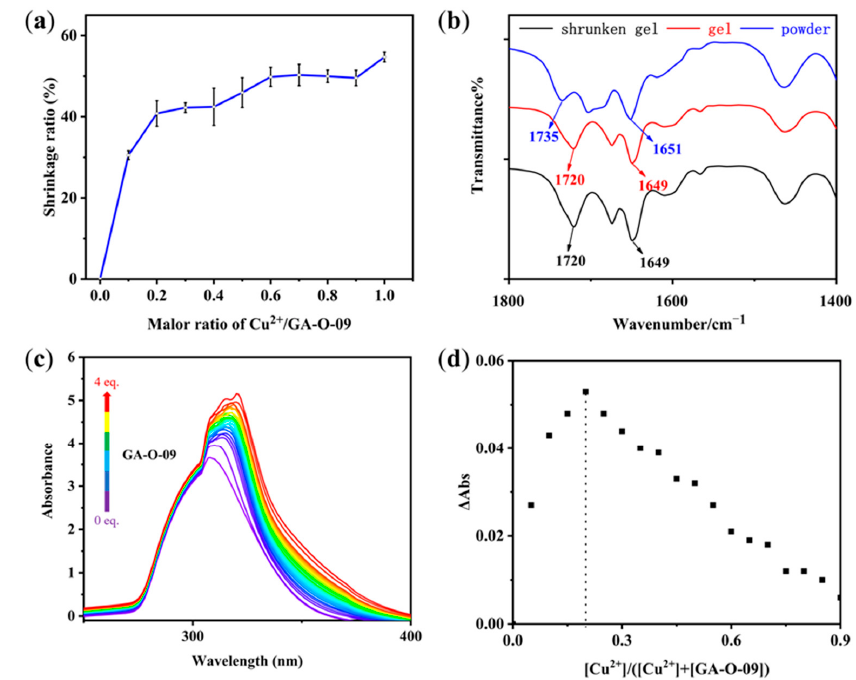
Figure 1. ( a ) Shrinkage ratio of the GA-O-09/Cu 2+ gel changed with the molar ratios of Cu 2+ and GA-O-09. ( b ) FT-IR spectra of GA-O-09 powder, GA-O-09 gel, and GA-O-09/Cu 2+ shrunken gel. ( c ) UV-vis titration of Cu 2+ with GA-O-09. CH 3 OH/CHCl 3 ( v / v , 1/2) was used as the solvent to preclude the formation of precipitates or gel during the titration. The concentration of Cu 2+ was at 7 mmol/L, and the concentration of GA-O-09 ranged from 0 to 28 mmol/L. ( d ) Job’s plot of UV-vis titration at 320 nm showing 1:4 complex formations between Cu 2+ and